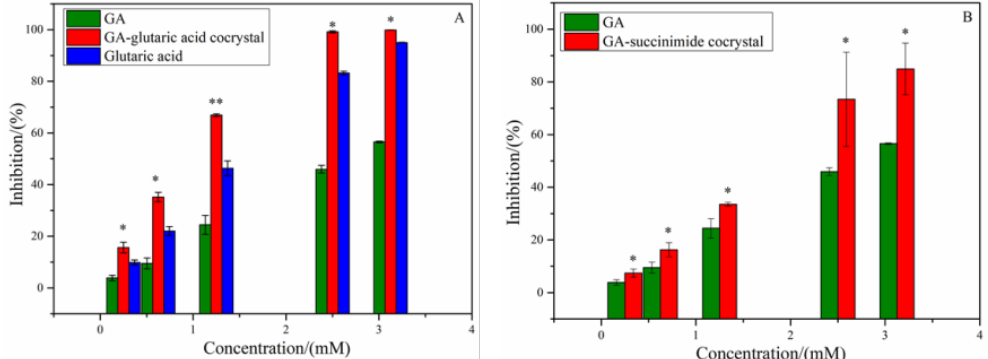
Table 1. Activities of GA, glutaric acid and cocrystals.